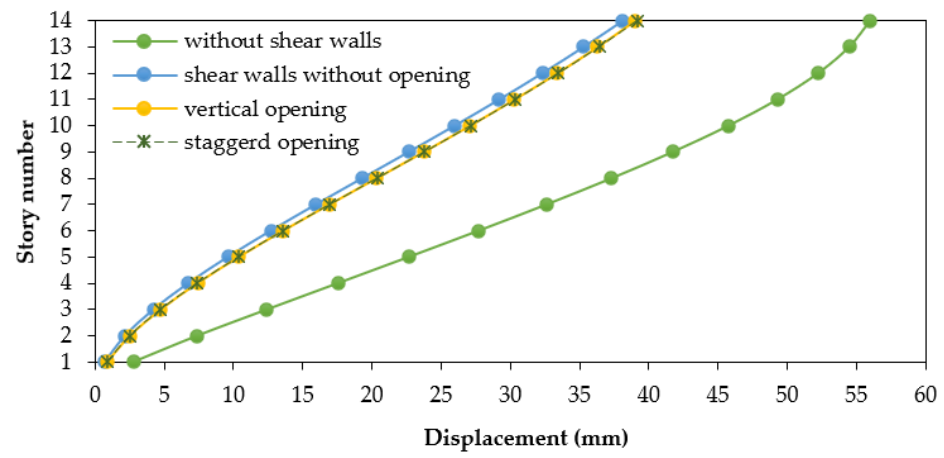
Figure 8. Story displacements, ESA in the Y-direction. Table 6. Comparison of the story displacements, response spectrum, and X-direction